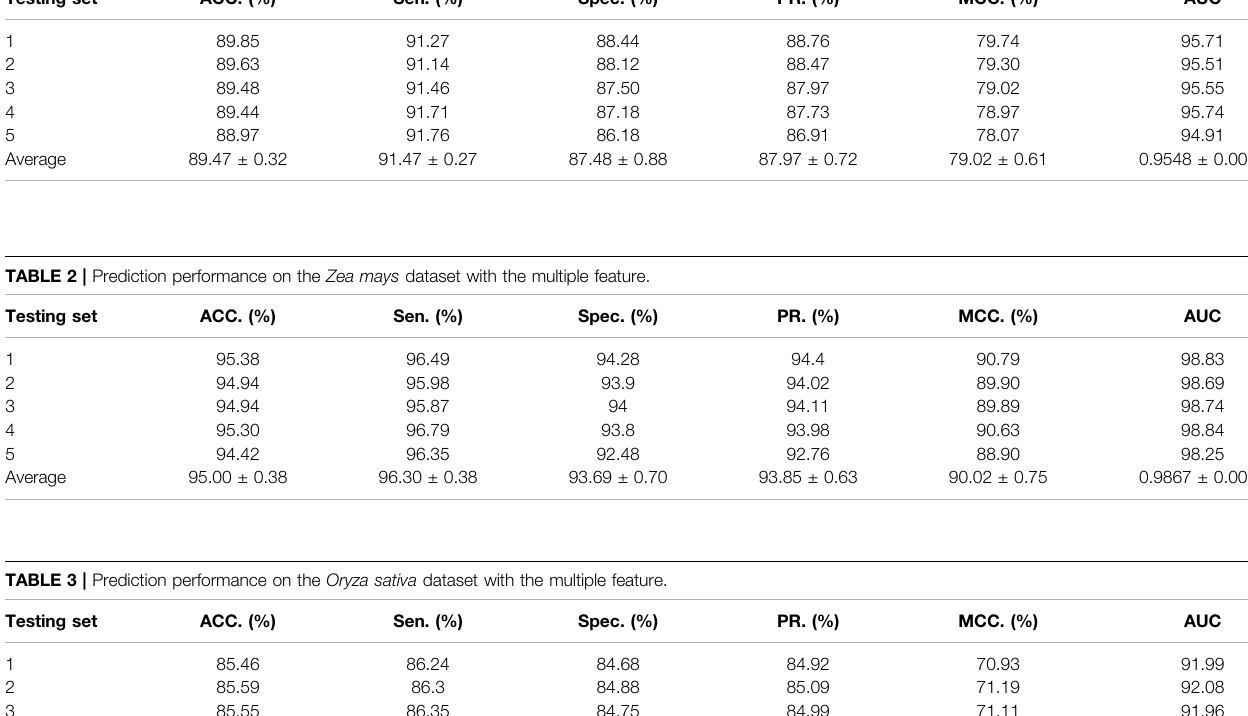
TABLE 1 | Prediction performance on the A. thaliana dataset with the multiple feature. Testing set